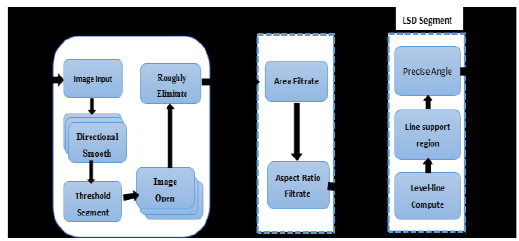
Figure1. The Framework of our method for barcode